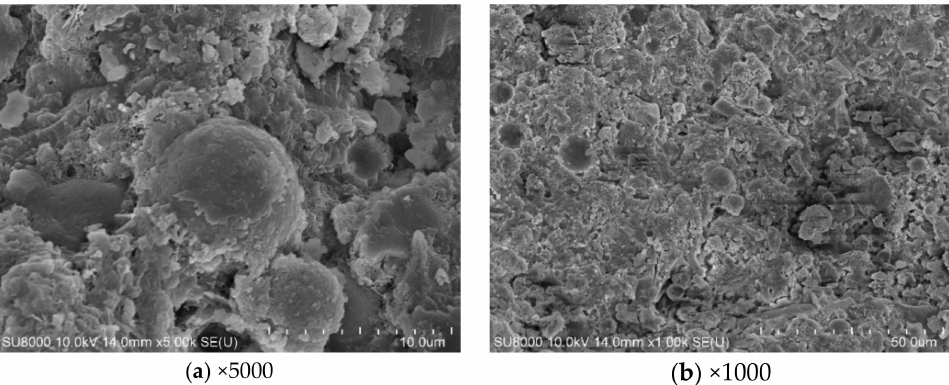
Figure 12. SEM images of sample containing RF. ( a ) × 5000. ( b ) × 1000.